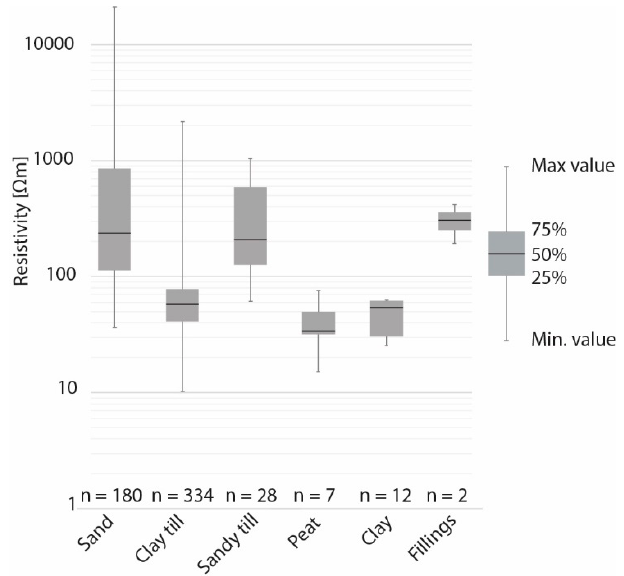
Figure 2. Box plot showing the resistivities of the different soil types observed within all the investigated areas. N represents the amount of measurements for each soil type.